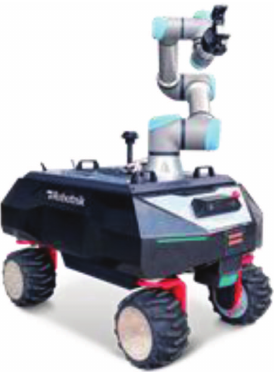
Fig. 7. CLEANDEM robotic solution